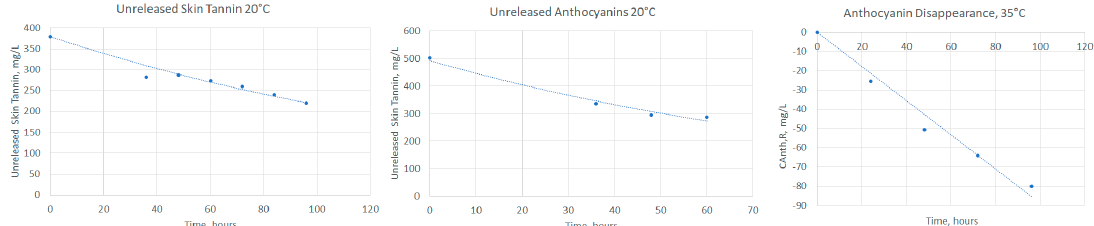
Figure 2. Kinetic fits for extraction phenomena. ( a ) Release of skin tannins at 20 °C with an integrated first order fit (y = 379.4 × e − 0.006x ). ( b ) Release of anthocyanins at 20 °C with an integrated first order fit (y = 492.5 × e − 0.01x ). ( c ) Anthocyanin disappearance at 35 °C with a zero-order fit (y = − 0.89x).